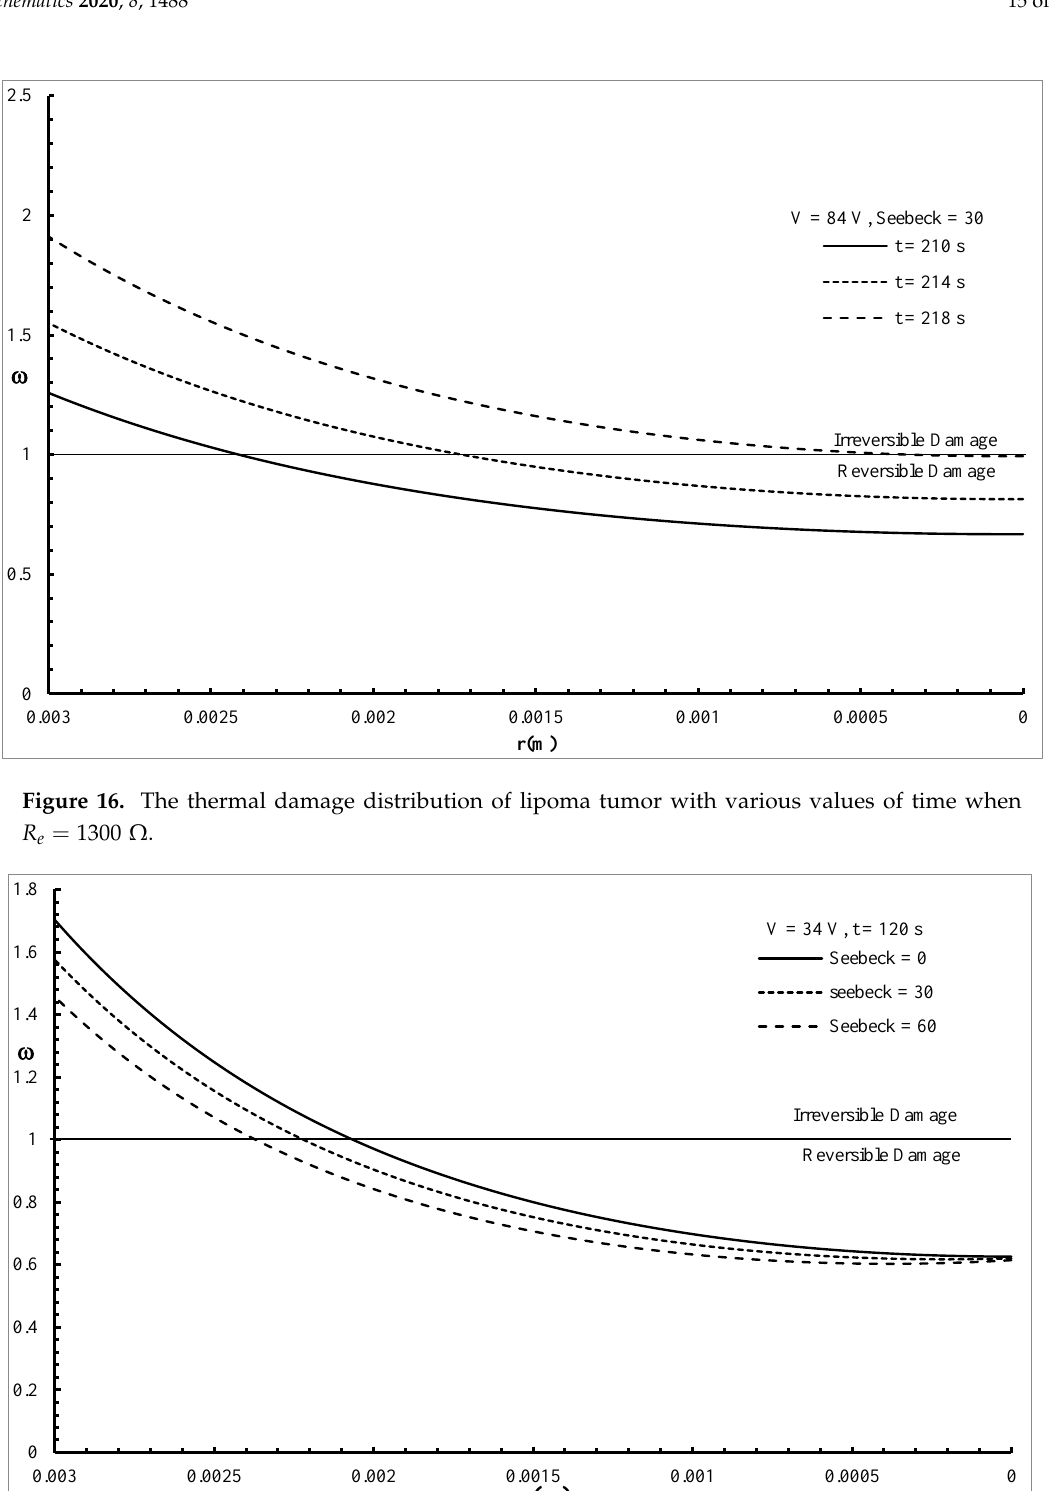
Figure 17 . The thermal damage distribution of myxoid liposarcoma tumor with various values of Figure 17. The thermal damage distribution of myxoid liposarcoma tumor with various values of the R   . the Seebeck coefficient when 75 Seebeck coe ffi cient when R e = 75 Ω e